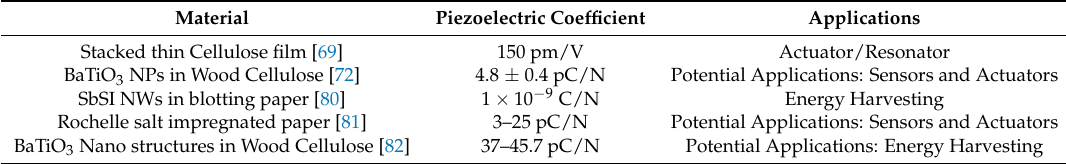
Table 4. Piezoelectric coefficients were reported in a recently developed piezo